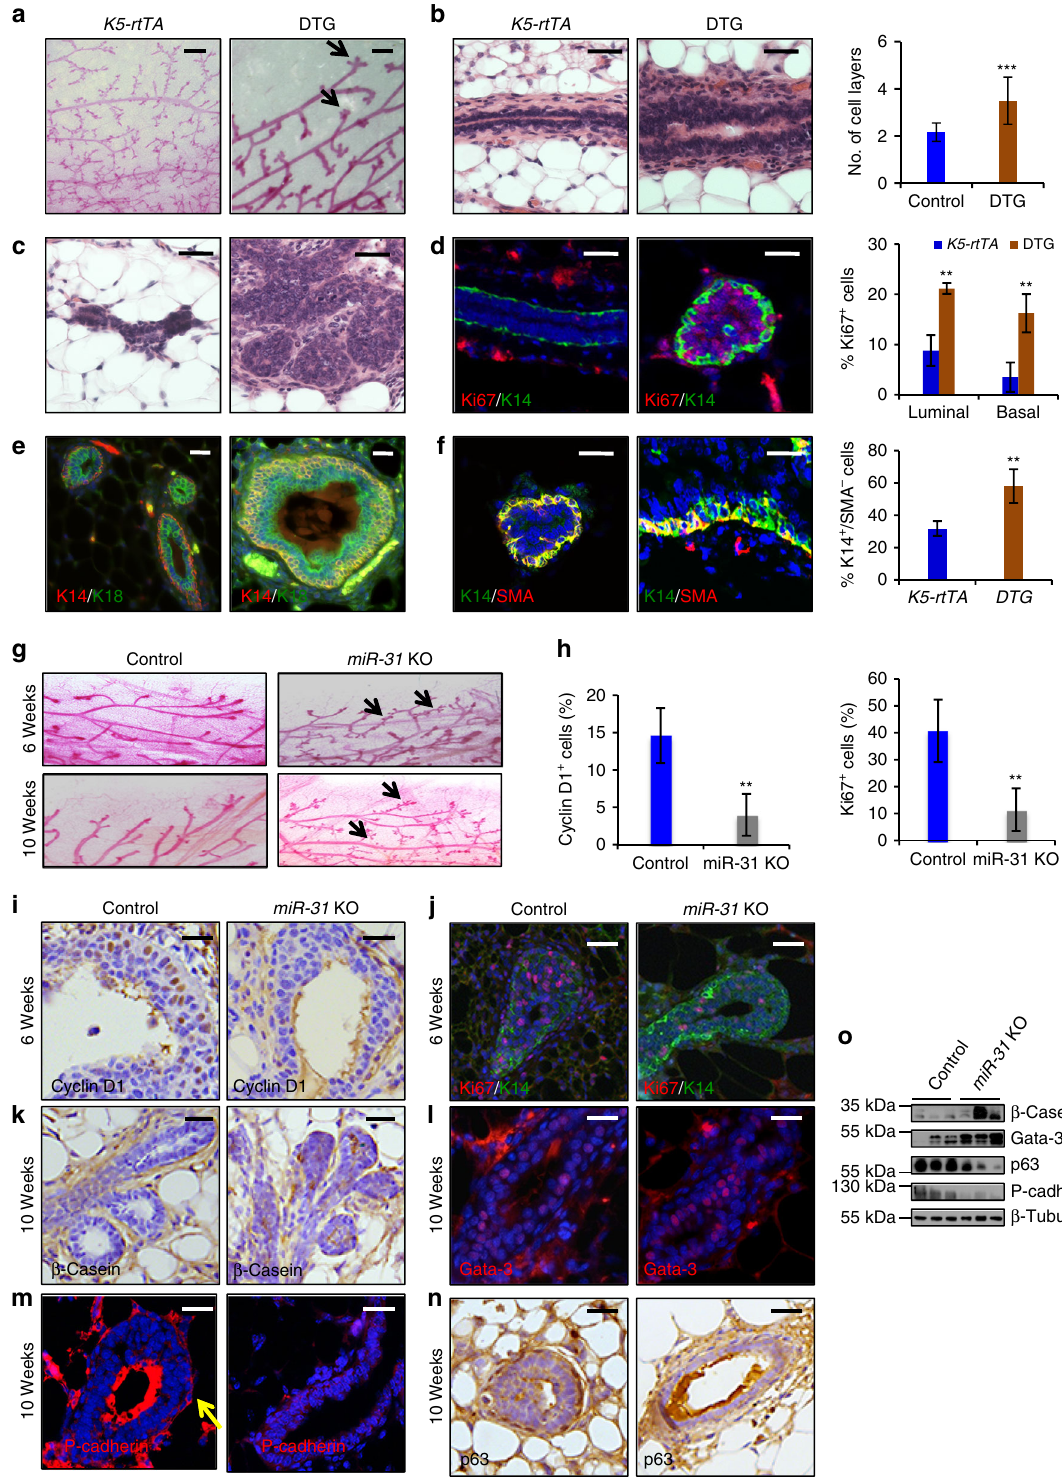
expression starting at 1 week of age by oral administration of Dox-containing water in the lactating females. Following wean- ing, pups were maintained on Dox-containing water until the end time point. Since Dox itself may affect mammary development, we compared mammary gland morphology from mice fed with either Dox or control water. We found that Dox administration mildly inhibited mammary branching and ductal elongation